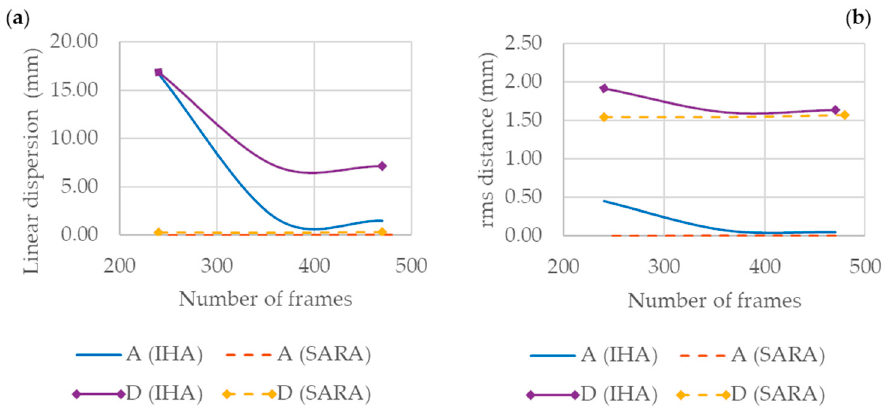
Figure 11. Linear dispersion ( a ) and rms distance ( b ) in A and D motion configurations, for different number of frames, obtained by increasing the joint motion speed. Results are shown for IHA (w.1) and SARA algorithms.